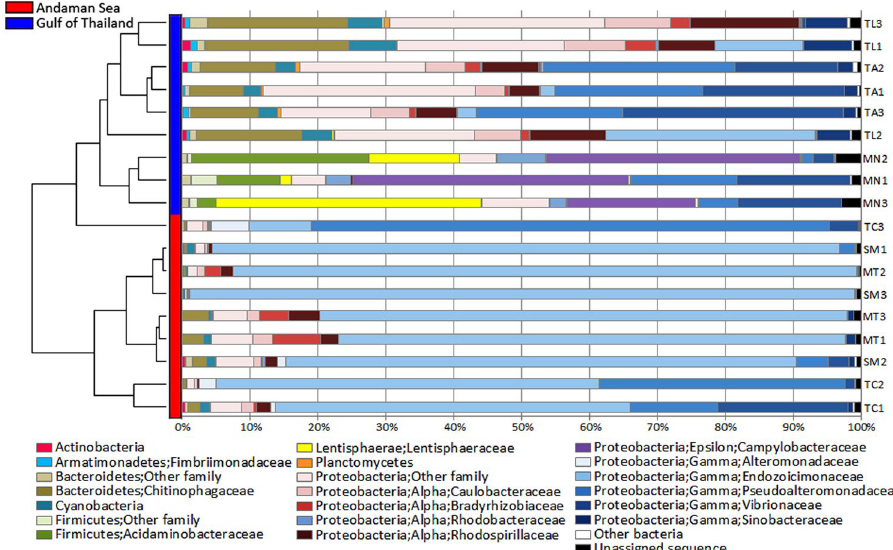
Figure 4. A dendrogram illustrating the similarities among the bacterial profiles of P. lutea microbiomes from different locations in the Gulf of Thailand and Andaman